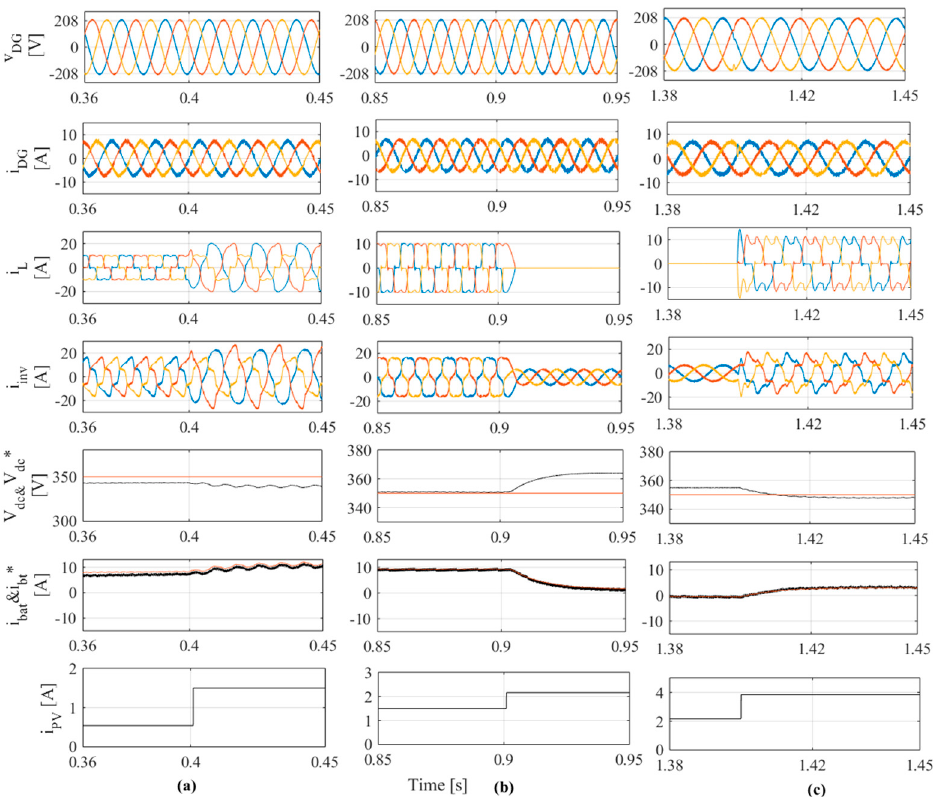
Figure 10. Zoom of the waveforms of Figure 6 between ( a ) t = 0.8s to t = 1 s, ( b ) t = 1.6 s to t = 1.8 s and ( c ) between t = 2.7 s to t = 2.9 s. ( c ) between t = 2.7 s to t = 2.9